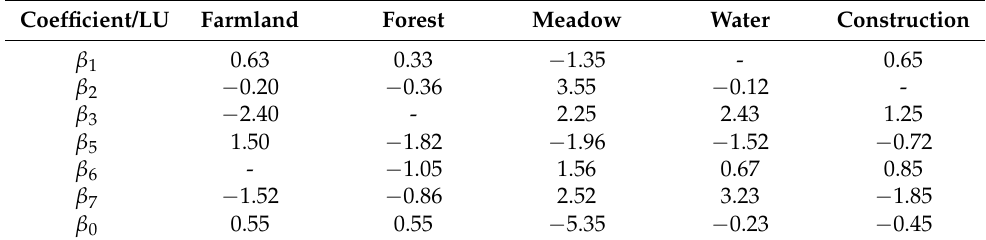
Table 2. The coefficient of binary logistic regression for each LU type. Coefficient/LU Farmland Forest Meadow Water Construction β